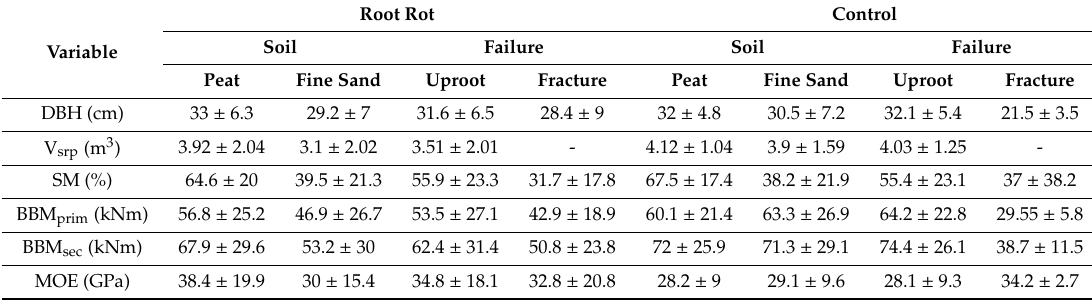
Table 2. Mean values and standard deviations of diameter at breast height (DBH), soil-root